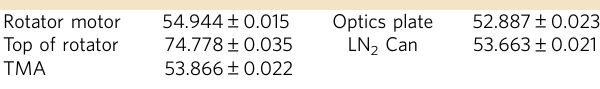
Table 1 | Internal NIRSPEC temperatures